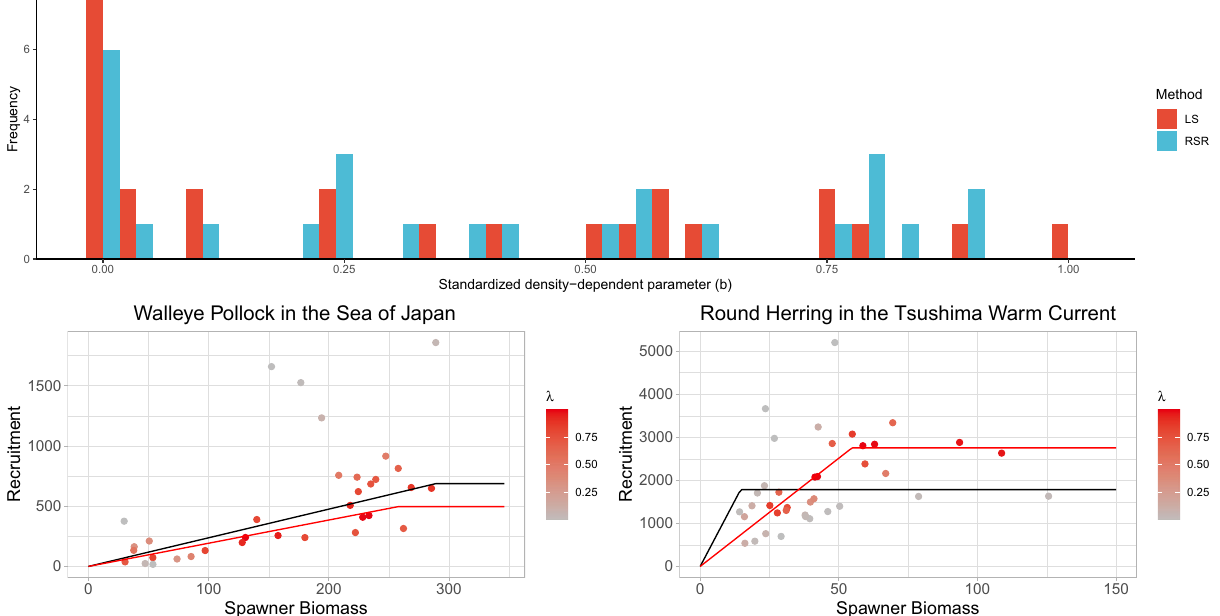
Figure 4. Application of the robust SR model to fish population data from Japan. (Top) Estimates of min ( S ))/( max ( S ) min ( S )) using the LS and RSR methods. (Bottom) Examples of fitted SR curves using ( b − − the LS (black line) and RSR (red line) methods (left, walleye pollock in the Sea of Japan; right, round herring in the Tsushima warm